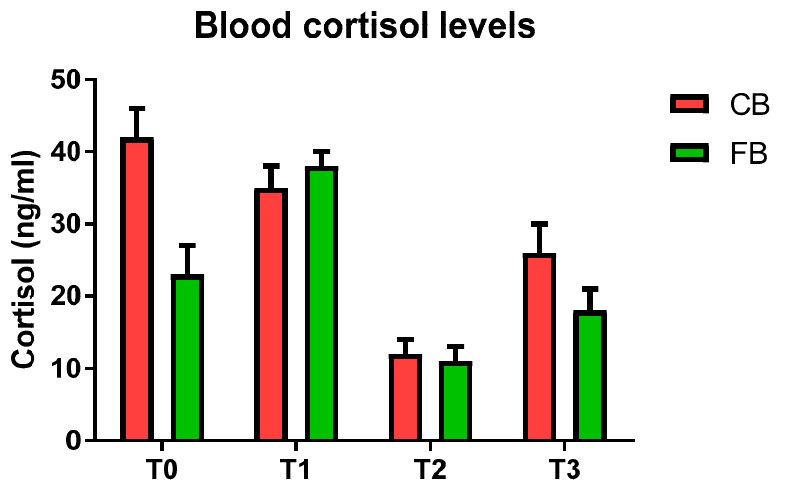
Figure 2. Blood cortisol levels (mean values ± SD) in the compost barn (CB) and the freestall barn (FB) groups.